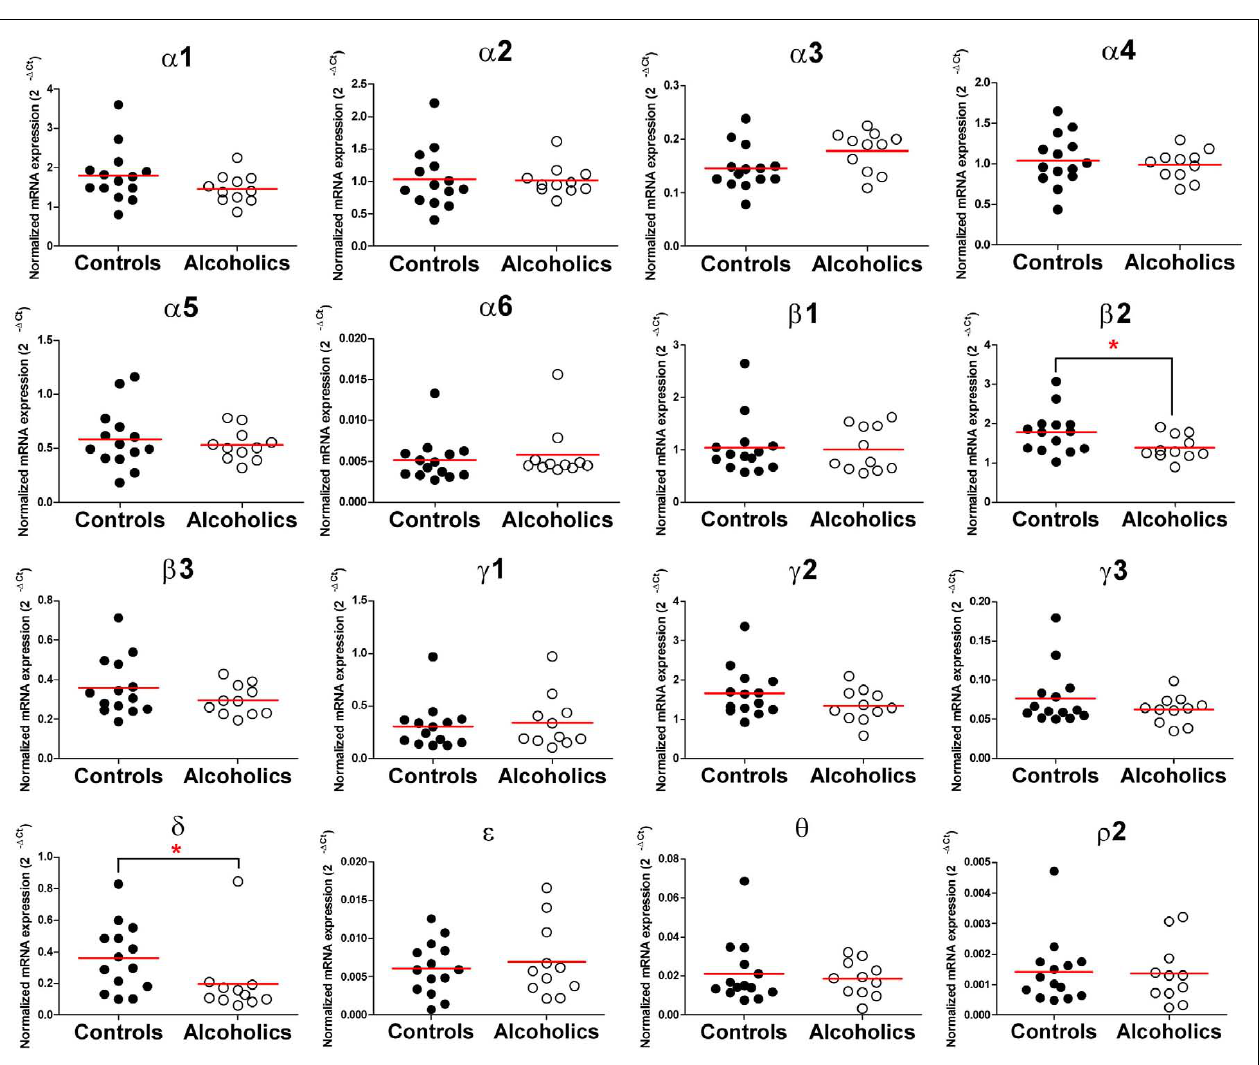
ranks with Dunn’s post hoc test, α 1, H (1, 25) = 2.03, p = 0.15; α 2, H (1, 25) = 0.3, p = 0.58; α 6, H (1, 25) = 0.51, p = 0.48; β 1, H (1, 25) = 0.05, p = 0.83; β 3, H (1, 25) = 1.09, p = 0.3; γ 1, H (1, 25) = 0.15, p = 0.70; γ 2, H (1, 25) = 1.59, p = 0.21; γ 3, H (1, 25) = 0.15, p = 0.70; θ , H (1, 25) = 0.003, p = 0.96; ρ 2, H (1, 25) = 0.003, p = 0.96; δ , H (1, 25) = 5.8, p =